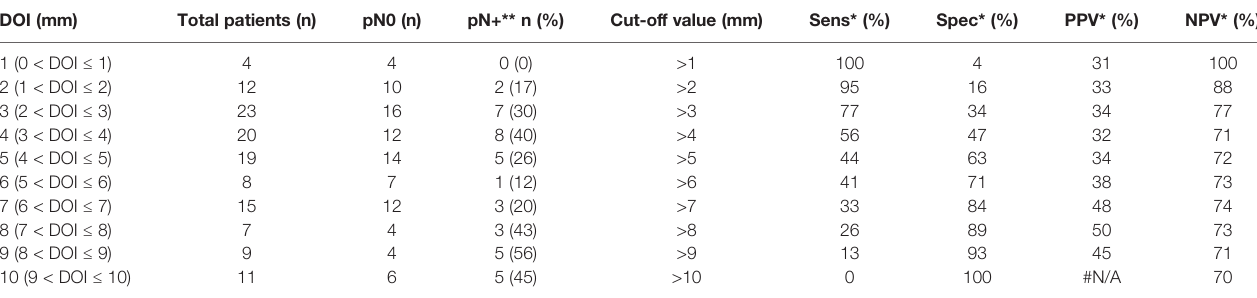
TABLE 4 | Association between depth of invasion and occult lymph node metastasis in tongue. DOI (mm) Total patients (n)